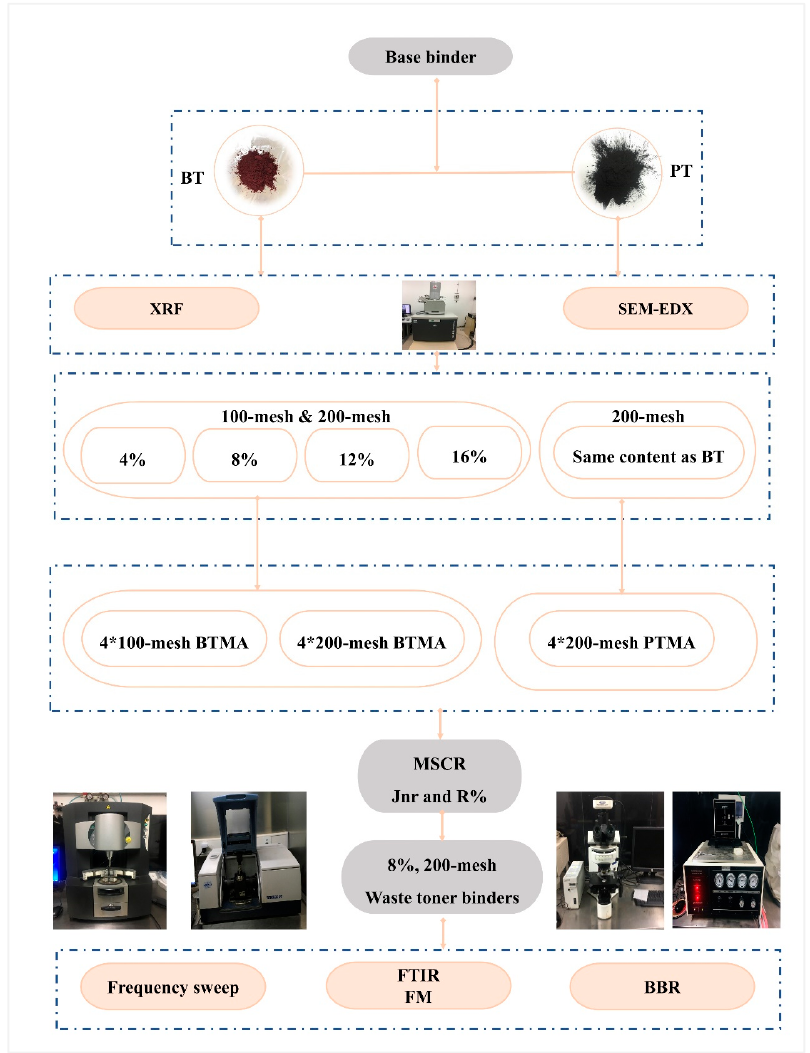
Figure 2. Flowchart of experimental design.